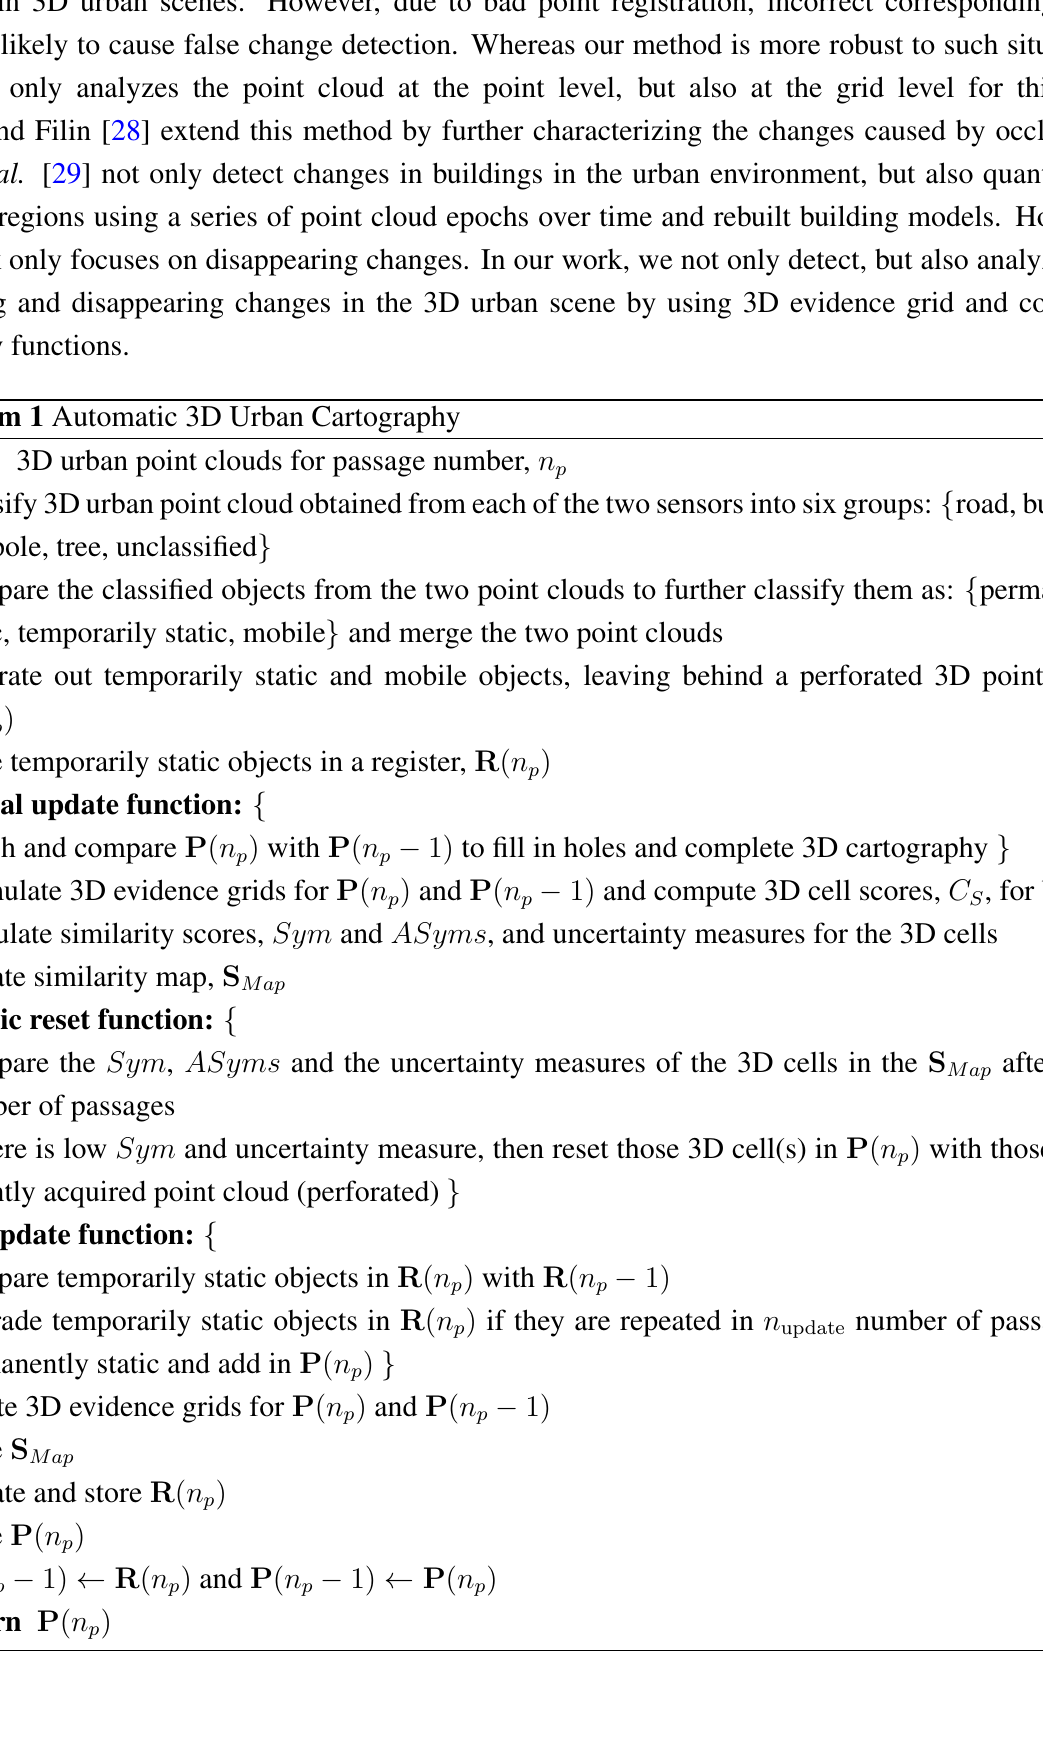
Algorithm 1 Automatic 3D Urban